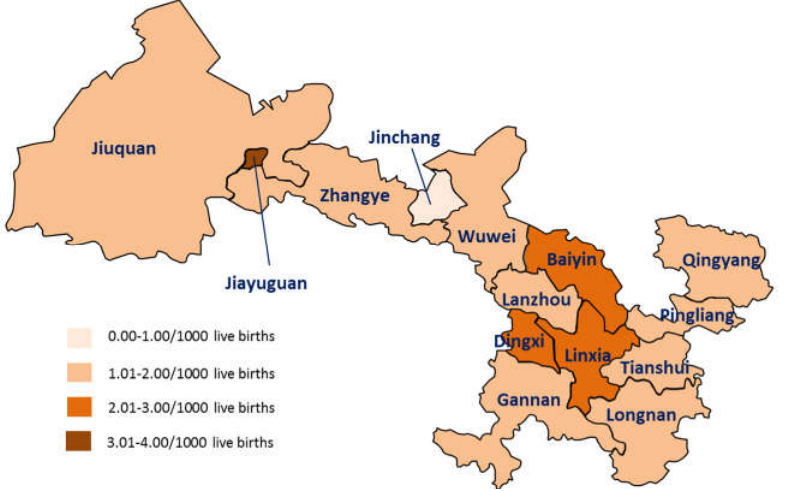
Figure 1. Prevalence of oral clefts in different cities in 2008 in Gansu Province. Table 3. The prevalence of oral clefts in different cities in 2008 in Gansu Province.